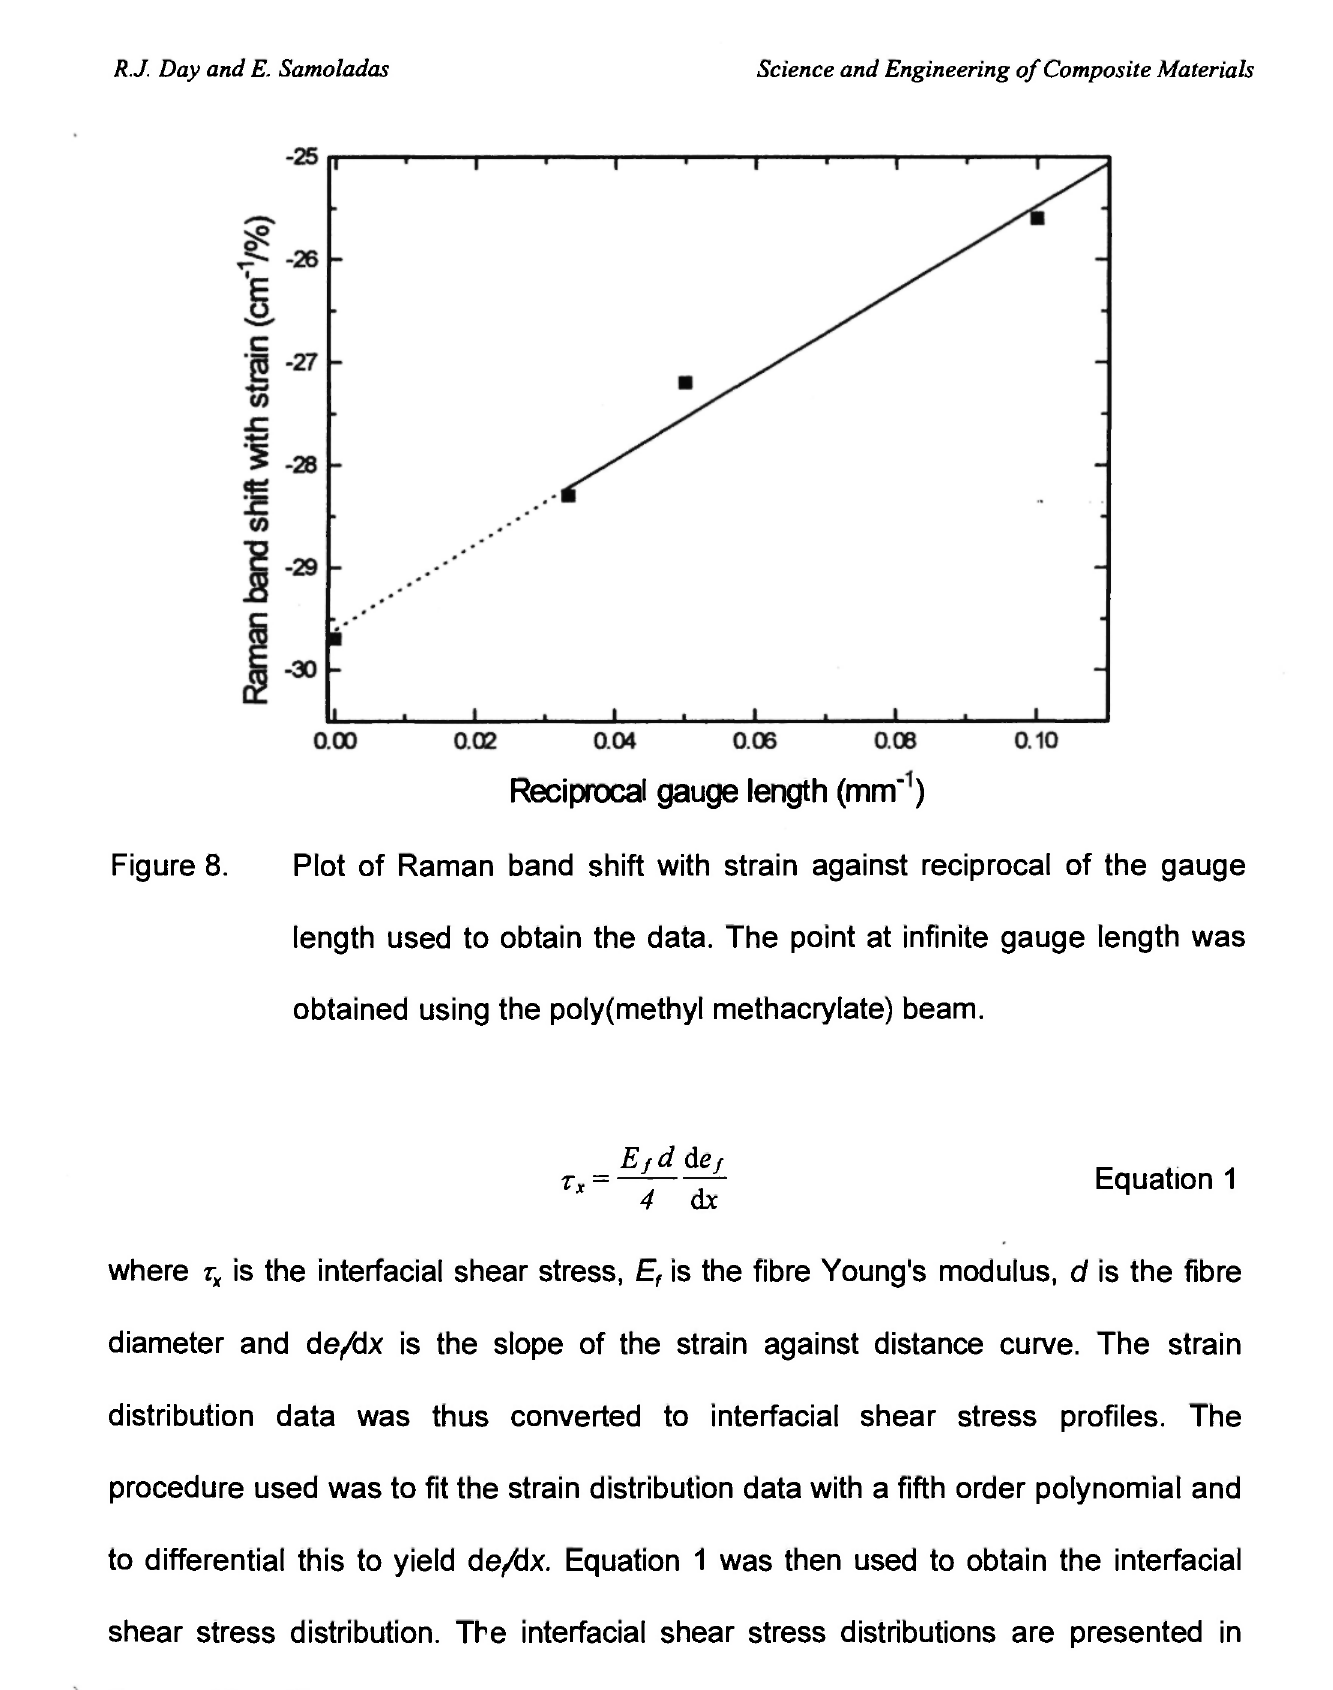
Reciprocal gauge length (mm") Figure 8. Plot of Raman band shift with strain against reciprocal of the gauge length used to obtain the data. The point at infinite gauge length was obtained using the poly(methyl methacrylate) beam.